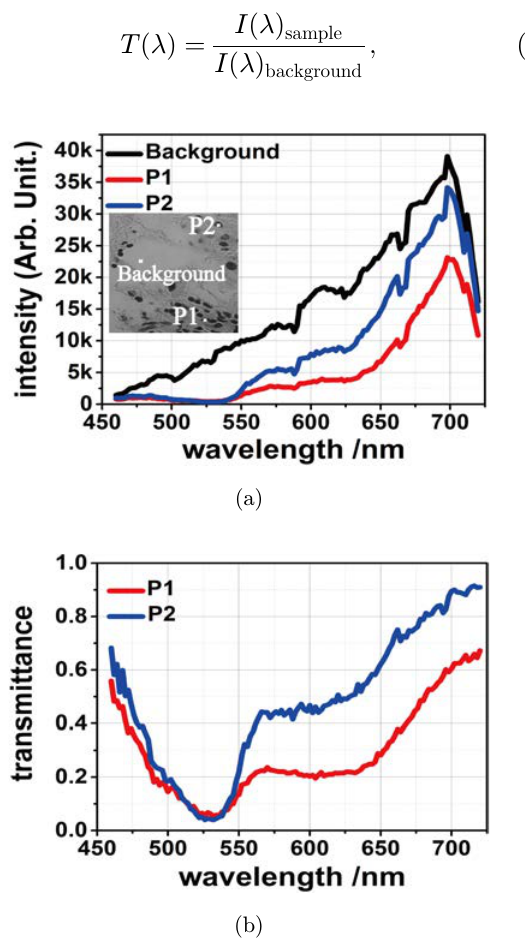
Fig. 2. Acquisition of transmittance spectrum. (a) Intensities of background point and target points as functions of wave- length. The inset depicts the target points (P1 and P2) and background point in image. (b) Transmittance spectra of target points.